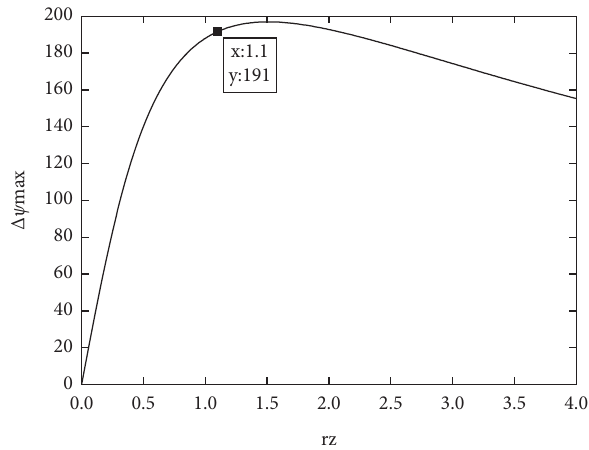
Figure 3: The relation curve of phase shift and the r